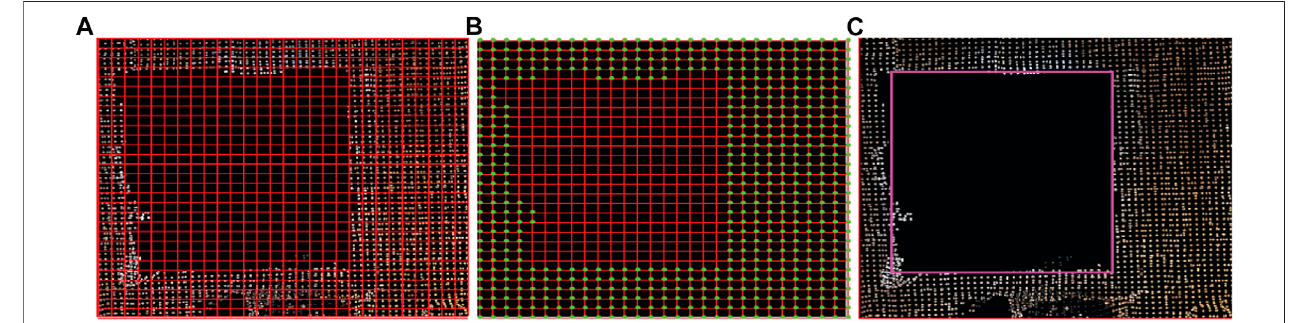
FIGURE 6 | Illustration of the openings detection. (A) Infrared light is not re fl ected by glass. (B) Sub-sampling of the data. (C) Detection of the minimal bounding box.